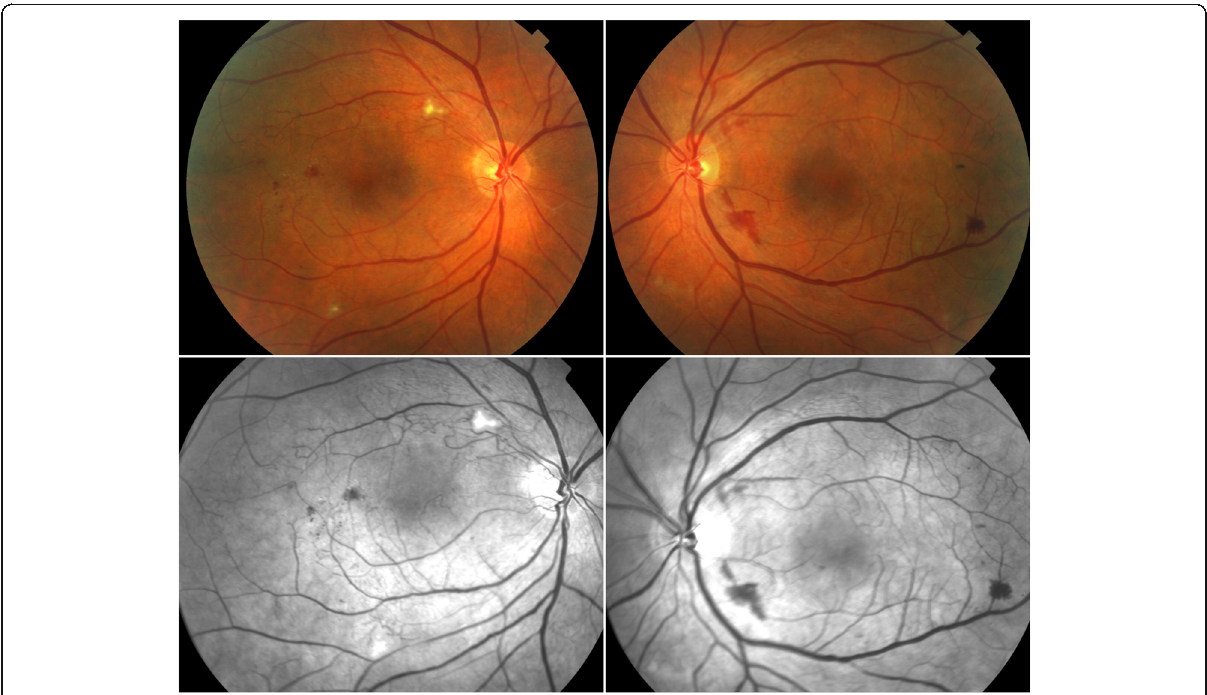
Fig. 1 Colour fundus photos ( top row ) and corresponding red-free images ( bottom row ). Occlusive retinopathy in the macular region, with vascular loops, collateralization, nerve fiber layer infarcts and pre − /intra-retinal hemorrhages is noted. The vessels show arteriolar narrowing with venular dilation and